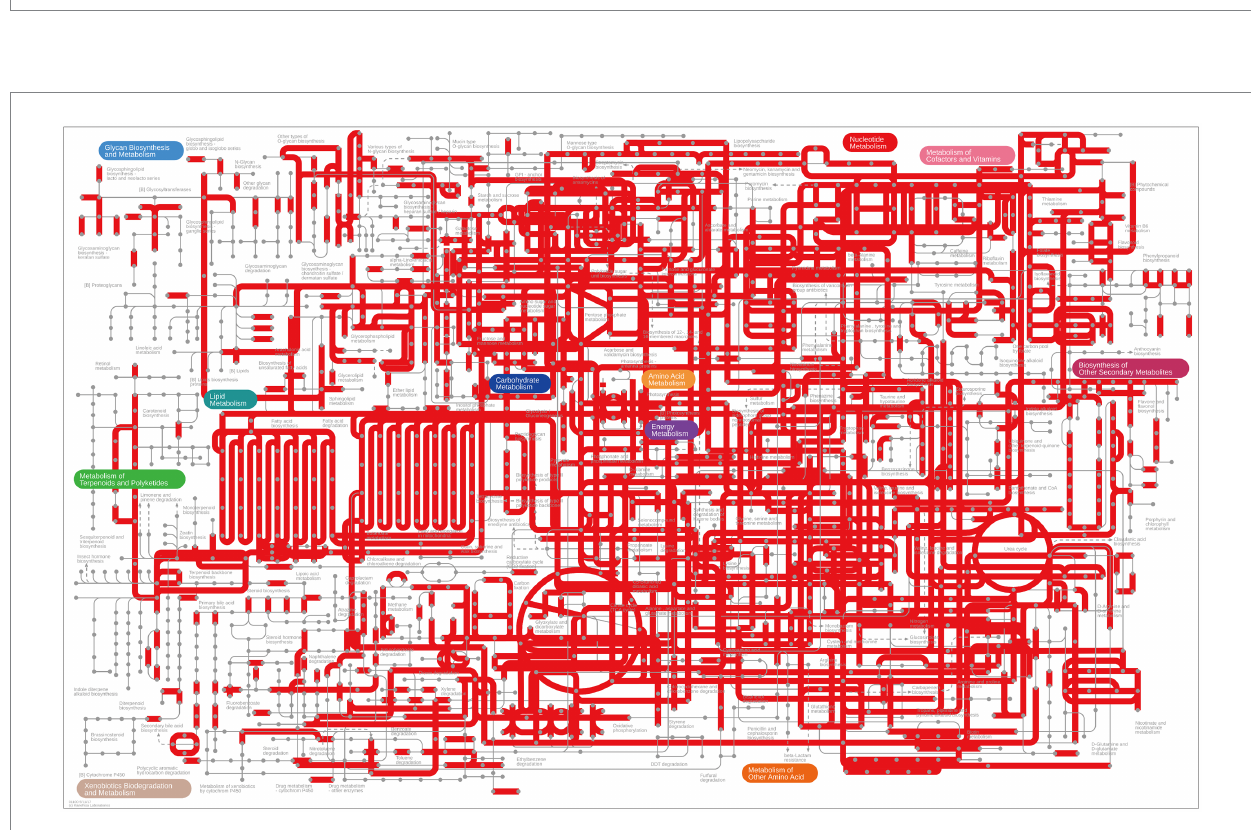
FIGURE 7 Overview of KEGG pathways of the gut microbiota, visualized using iPath.